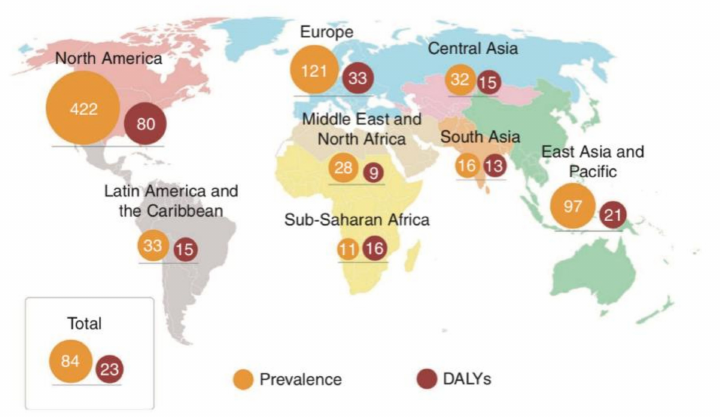
Figure 1. Age-standardized estimates of the regional and global prevalence of IBD (per 100,000 popu- lation), as expressed by 2017 disability-adjusted life year (DALY) rates (per 100,000 person-years)